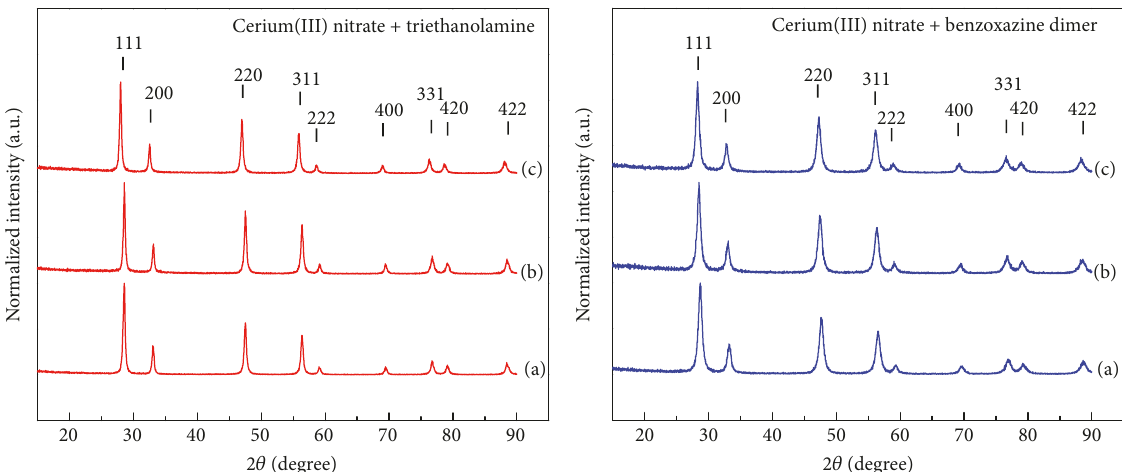
Figure 1: XRD patterns of the obtained products of (a) ceria after the thermal decomposition of the metal complex at 600 ∘ C for 2h, further used as a catalytic support; (b) ceria support after microwave-assisted wetness impregnation of palladium(II) nitrate (3% mole); (c) Pd- impregnated ceria catalyst after calcination under reduced atmosphere of 10% H 2 in He stream at 700 ∘ C for 2h, denoted as 3Pd-CeO2-T-N (red curves) and 3Pd-CeO2-B-N (blue curves) with regard to the use of cerium(III) nitrate to prepare metal complexes with triethanolamine and benzoxazine dimer ligand,